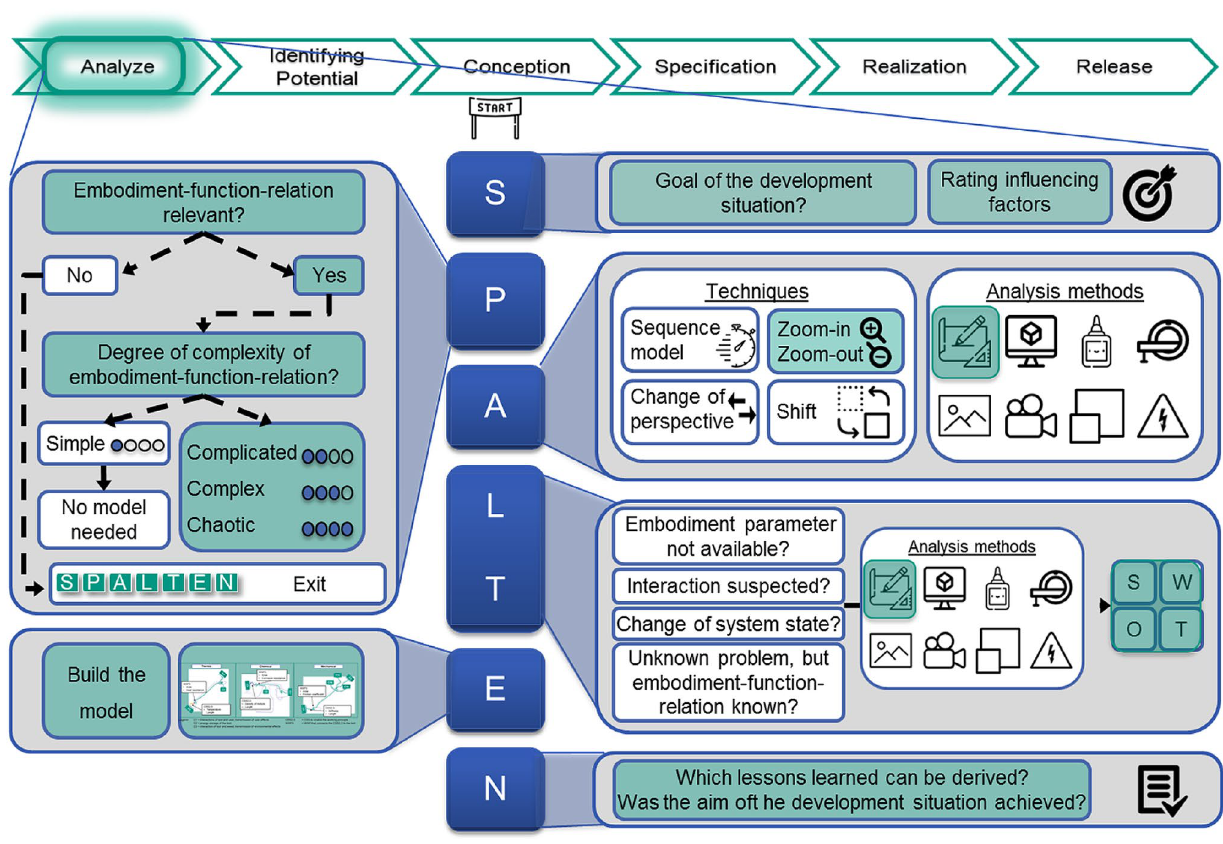
Fig. 8 Usage of the guideline in the Analyze Phase of the weed control project